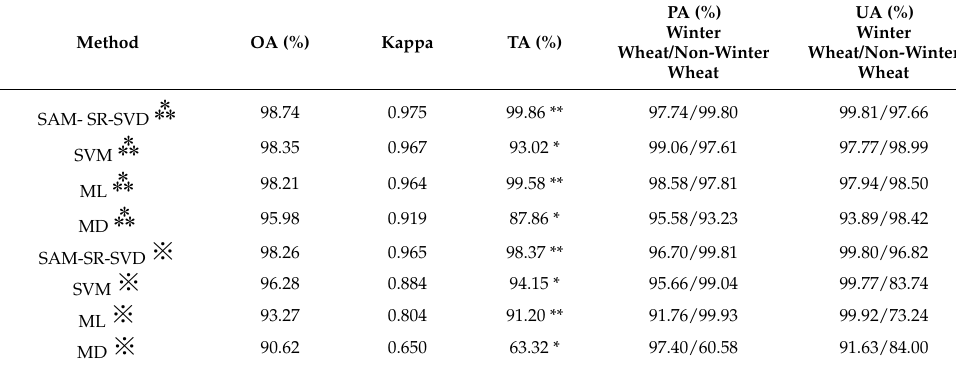
Figure 7. Winter wheat mapping results in Puyang County ( a ) and Shenzhou City ( b ) based on SAM-SR-SVD.